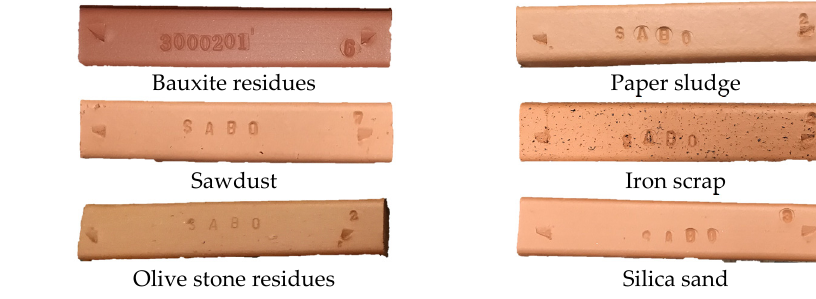
Figure 14. Surface color and appearance of the sample bodies constructed from the tested mixtures.